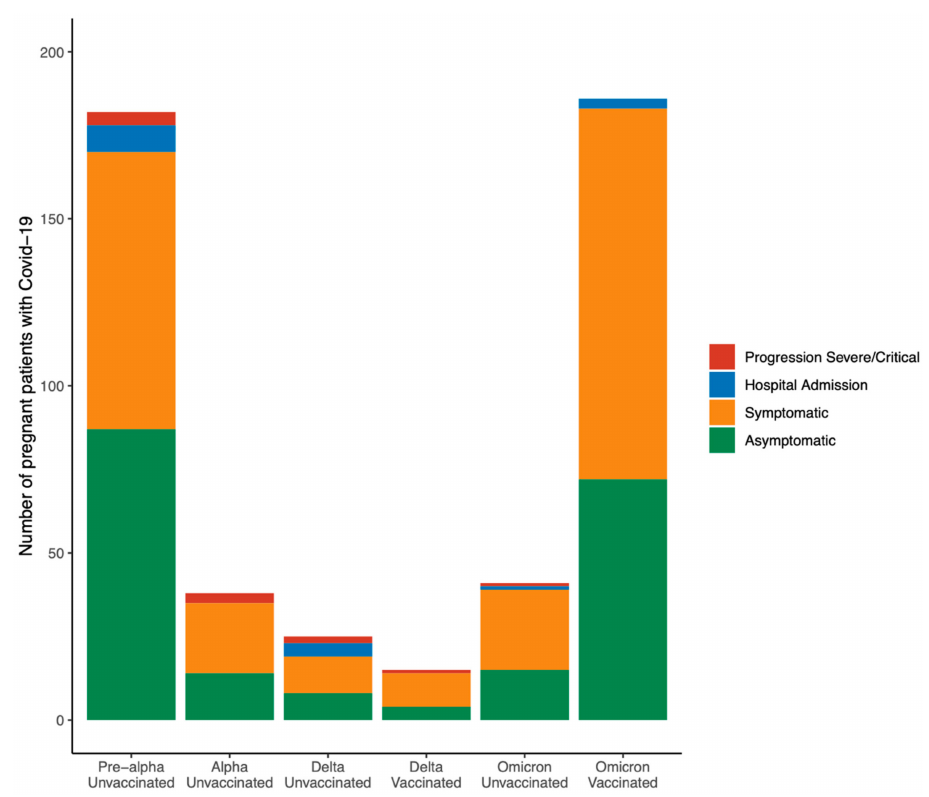
Figure 5. Progression to severe COVID-19 among vaccinated pregnant women with SARS-CoV-2 infection according to the SARS-CoV-2 strain predominance and vaccination status. Severe COVID-19 was defined as at least one of the following: admission to the intensive care unit, intubation, or extracorporeal membrane